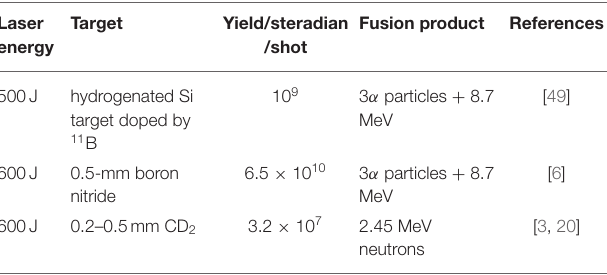
TABLE 1 | Yield of p + 11 B → 3 α + 8.7MeV and D + D → 3 He (0.82 MeV) + n (2.45 MeV) fusion reactions performed at the PALS facility. Laser energy